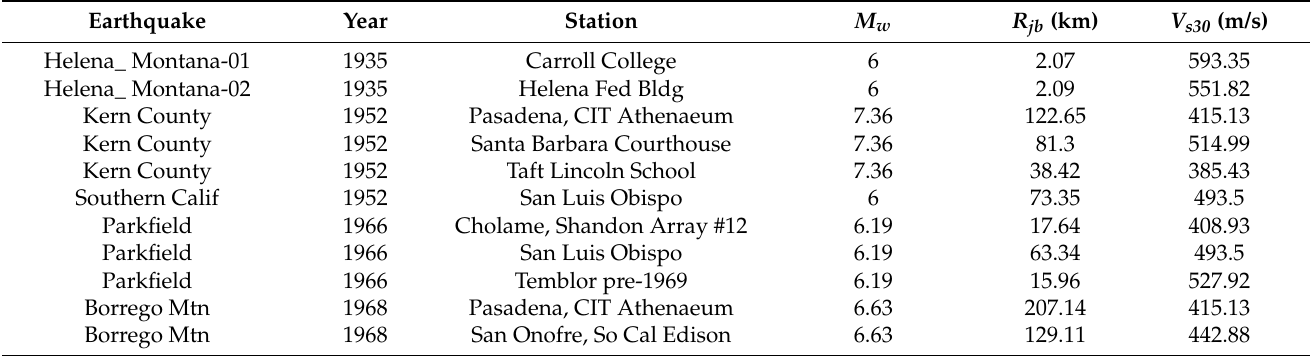
Table 1. Details of ground motions consistent with hard soil.